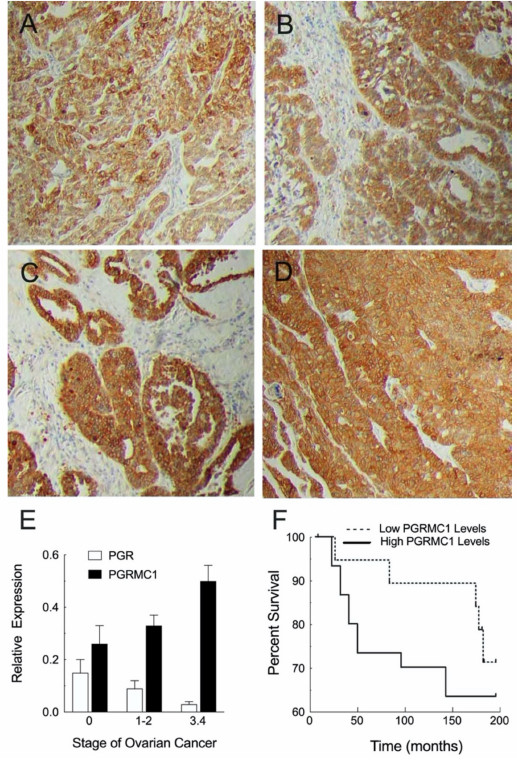
Figure 1. The localization of PGRMC1 in ovarian cancers: clear cell carcinoma ( A ), endometroid carcinoma ( B ), papillary serous cystadenocarcinoma—stage IIB ( C ), and papillary serous cystadenocarcinoma stage IIIC ( D